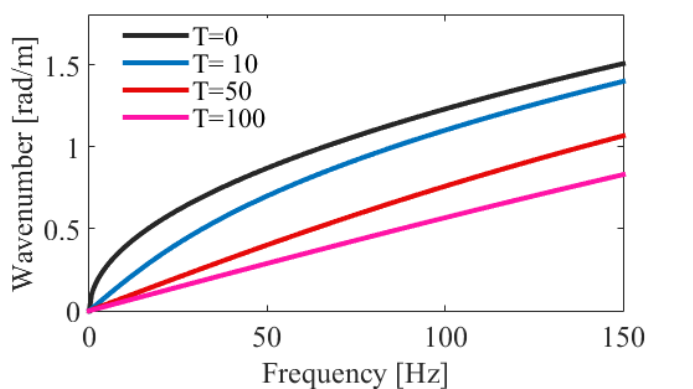
Figure 10. Cable dispersion diagram for the different tensile loads (N).